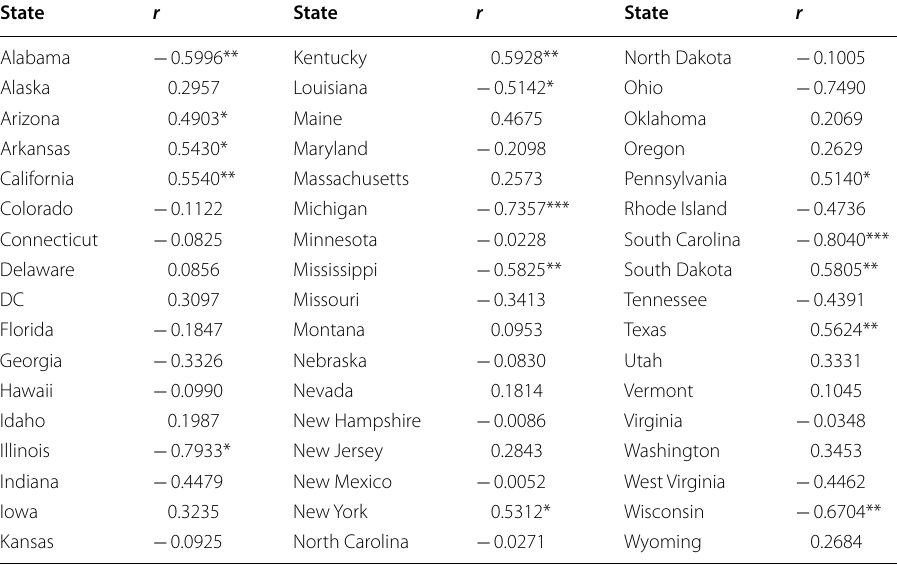
Table 3 Correlations between Google Trends data and Gonorrhea cases by state